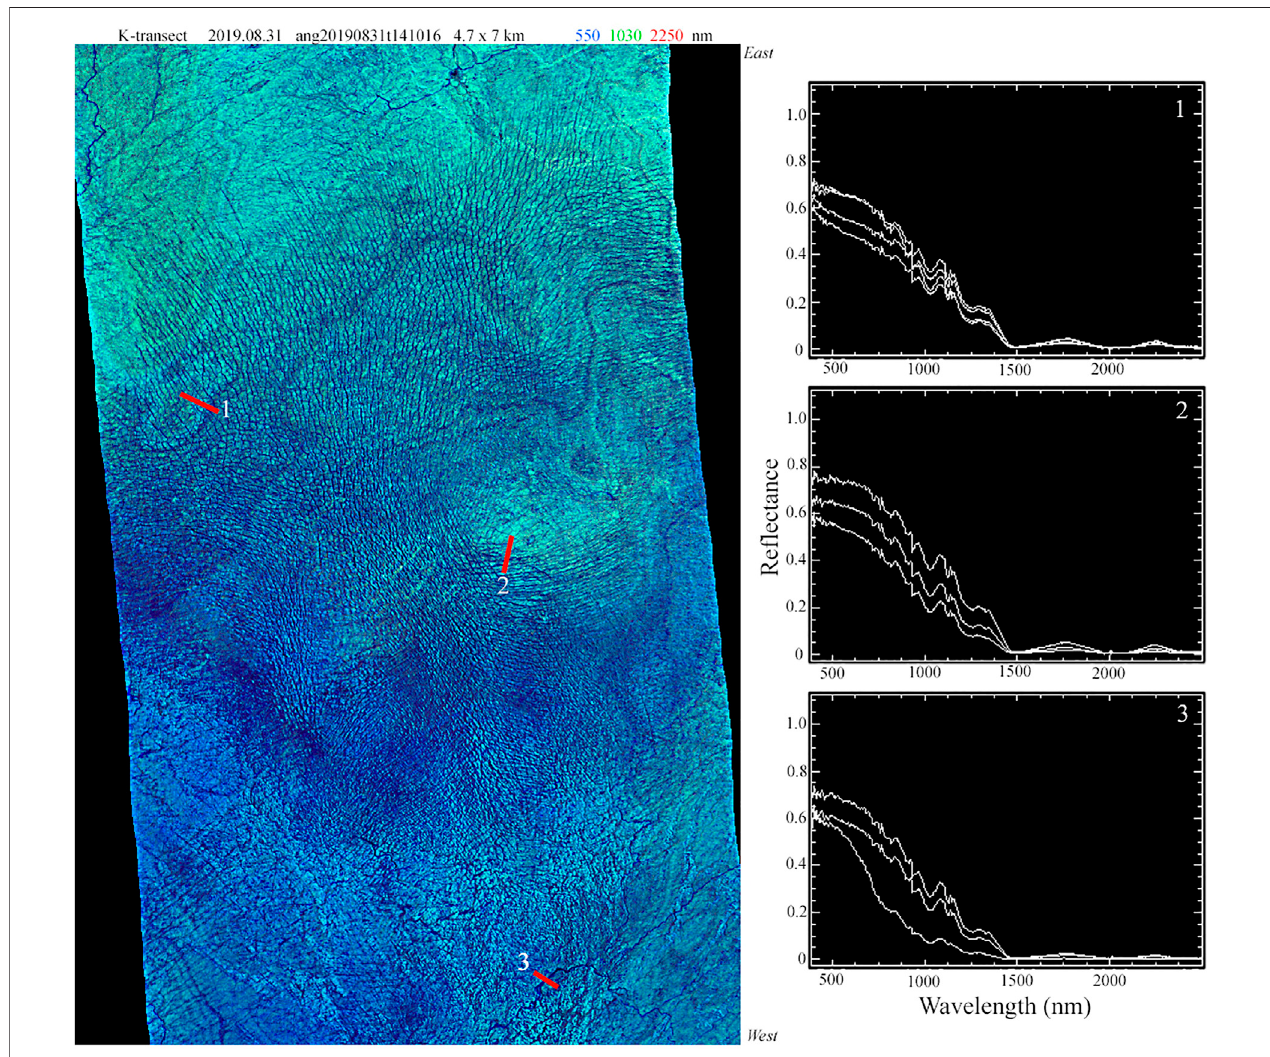
FIGURE 9 | Full resolution AVIRIS-NG swath and spectra from the K-transect transition zone. Variations in re fl ectance and illumination geometry reveal crevasse texture and lower albedo strata within the ice. Example spectra from adjacent, or near-adjacent, pixels show meter to decameter scale variations in fi rn and ice re fl ectance that would contribute to the spectral mixing occurring within decameter satellite imagery. Ground sample distance is 7.2 m.